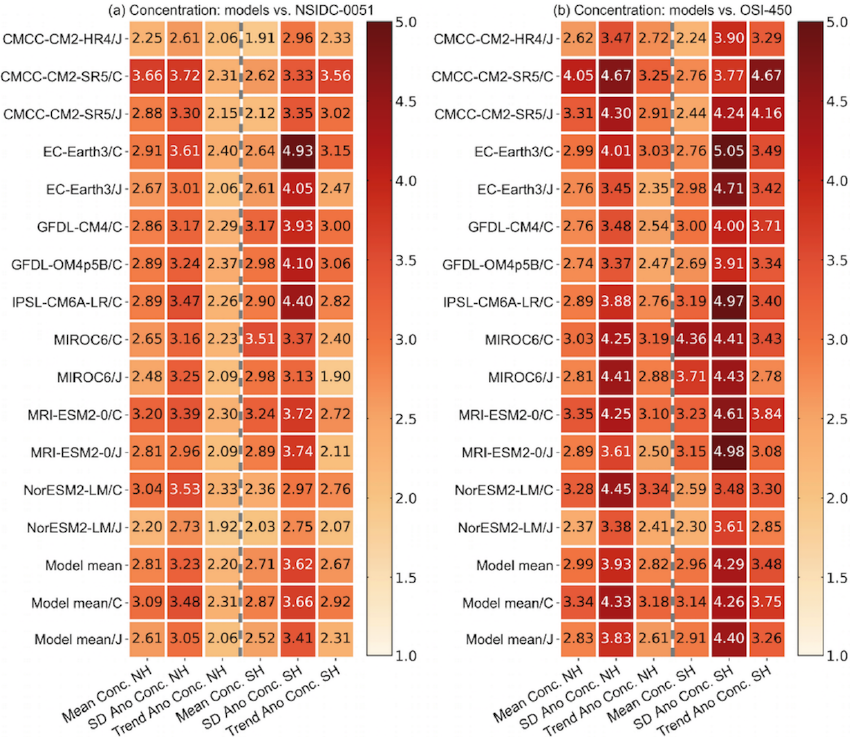
Figure 2. The ice concentration metrics of 14 model outputs under OMIP1 (/C) and OMIP2 (/J) protocols, 14-model mean (model mean), five-OMIP1-model mean (model mean/C), and five-OMIP2-model mean (model mean/J) from CMCC-CM2-SR5, EC-Earth3, MIROC6, MRI-ESM2-0, and NorESM2-LM compared to (a) NSIDC-0051 and (b) OSI-450 data. The six columns correspond to model performance metrics on the mean state, standard deviation (SD Ano), and trend (Trend Ano) of monthly anomalies of the Arctic and Antarctic ice concentration during 1980–2007. Lower values indicate better